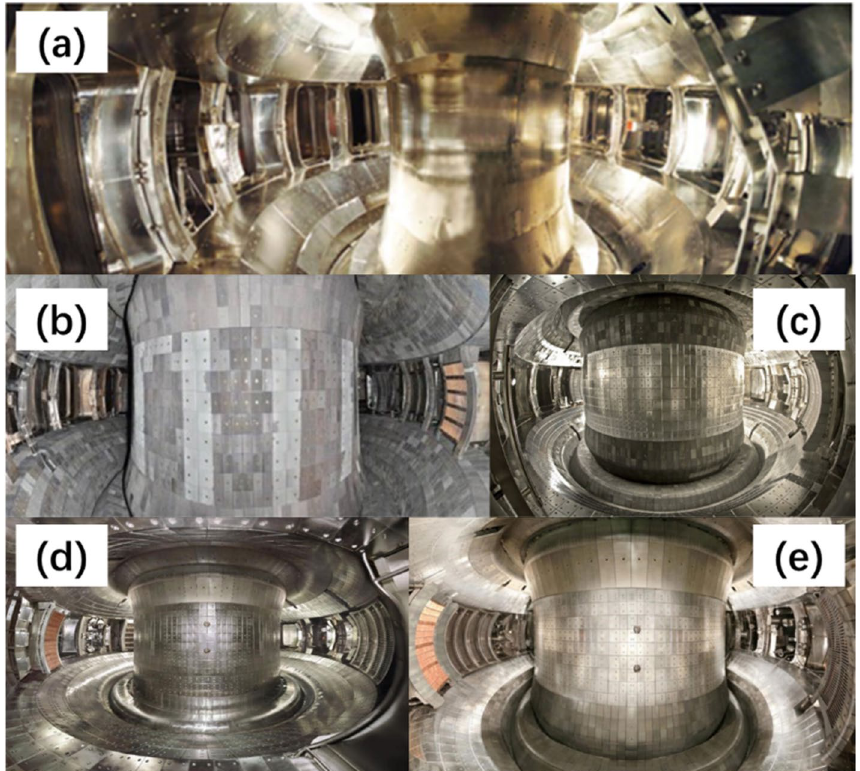
Fig. 3 In-vessel view of PFC on EAST. a Full – SS for the first plasma. b Full carbon, 2008–2012. c Carbon divertor and TZM FW, 2012–2014. d W upper Div. & C lower Div. & TZM FW, 2014–2020. e W upper Div. & W lower Div. & TZM FW, 2020 to